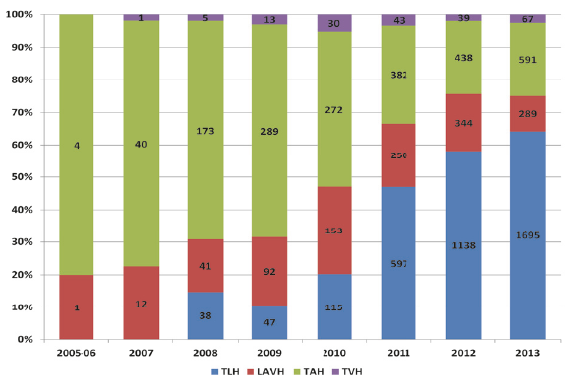
Figure 2: Frequency and proportion of different types of hys- terectomies performed among patients with a diagnosis of uter- ine cancer, ACS-NSQIP, 2005-2013 . TAH: total abdominal hys- terectomy; TVH: total vaginal hysterectomy; LAVH: laparoscopic assisted vaginal hysterectomy; TLH: total laparoscopic hysterec- tomy.